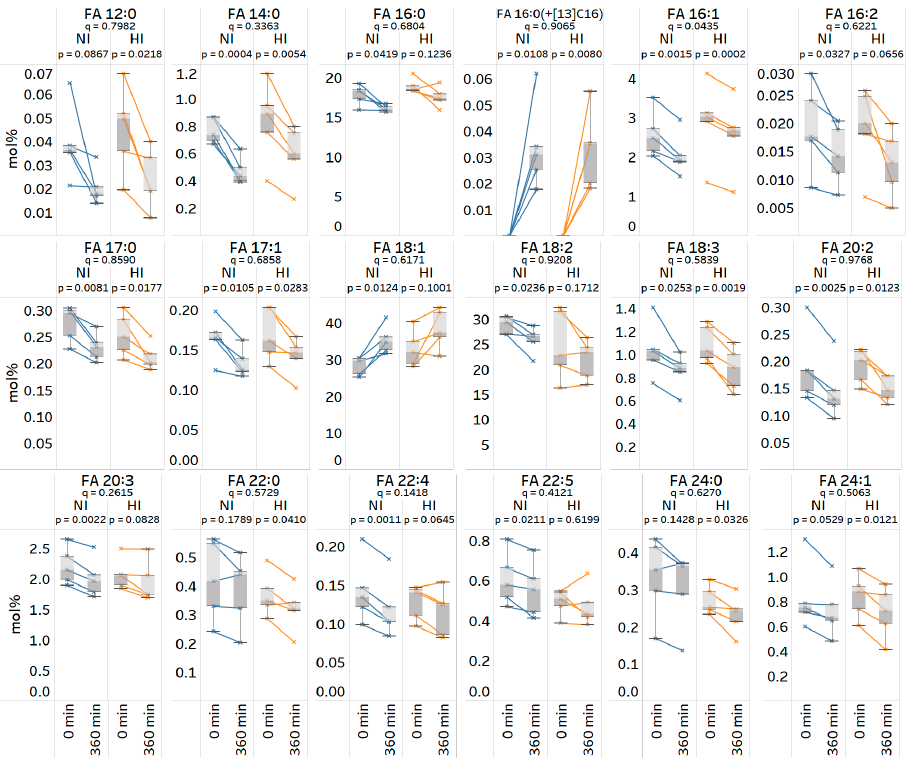
Figure 7. Total fatty acyl (FA) profiles of normoinsulinemic (NI) and hyperinsulinemic (HI) subjects at 0 h (baseline) and 6 h after intake of FA 16:0(+ 13 C 16 ). Plasma lipids were subjected to acid-catalyzed hydrolysis with H 218 O and analyzed by high resolution Fourier transform mass spectrometry (FTMS). Interconnected data points in box plots represent repeated measurements from five individuals within each group. p -values are based on paired, two-sided t -tests of differences within each subject group. q -values are based on unpaired, two-sided t -tests of time-dependent differences between the two groups. p - and q -values below 0.05 are considered statistically significant.